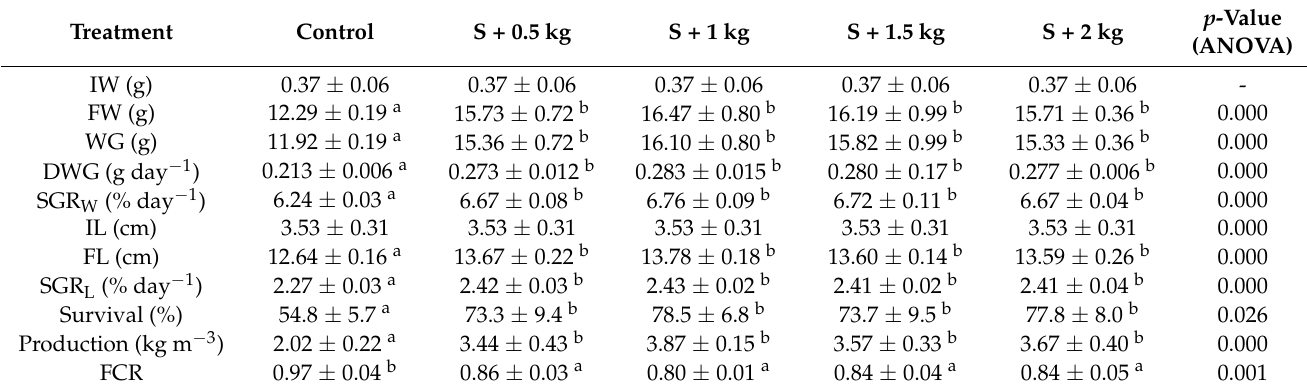
Table 4. Effects of polyculture of different densities of sea grape with shrimp on the growth, survival, production, and feed conversion ratio (FCR) of shrimps after 56 days of